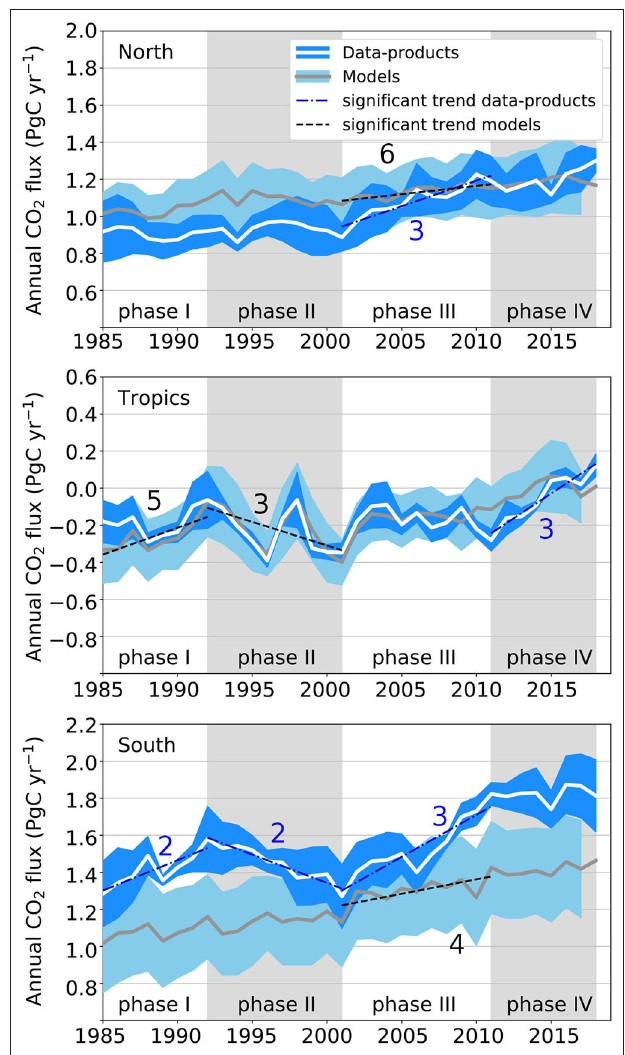
FIGURE 5 | Multi-year variability of regional air-sea CO 2 flux with agreement among methods on no significant or a decreasing trend in phase II and an increasing trend in the extratropics in phase III. Shown are the average and standard deviation of annual CO 2 flux for the ensemble of data-products and the ensemble of Global Ocean Biogeochemical Models (GOBMs) in the north (top), tropics (center) and south (bottom). Broken lines represent significant trend over that time-period. Numbers indicate the number of individual data-products and GOBMs that agree on the significant trend and are only given if the trend of the ensemble average is also significant. Note the different scales for different regions. Horizontal lines have the same distance in all subfigures (0.2 PgC yr − 1 ). Positive: CO 2 flux into the